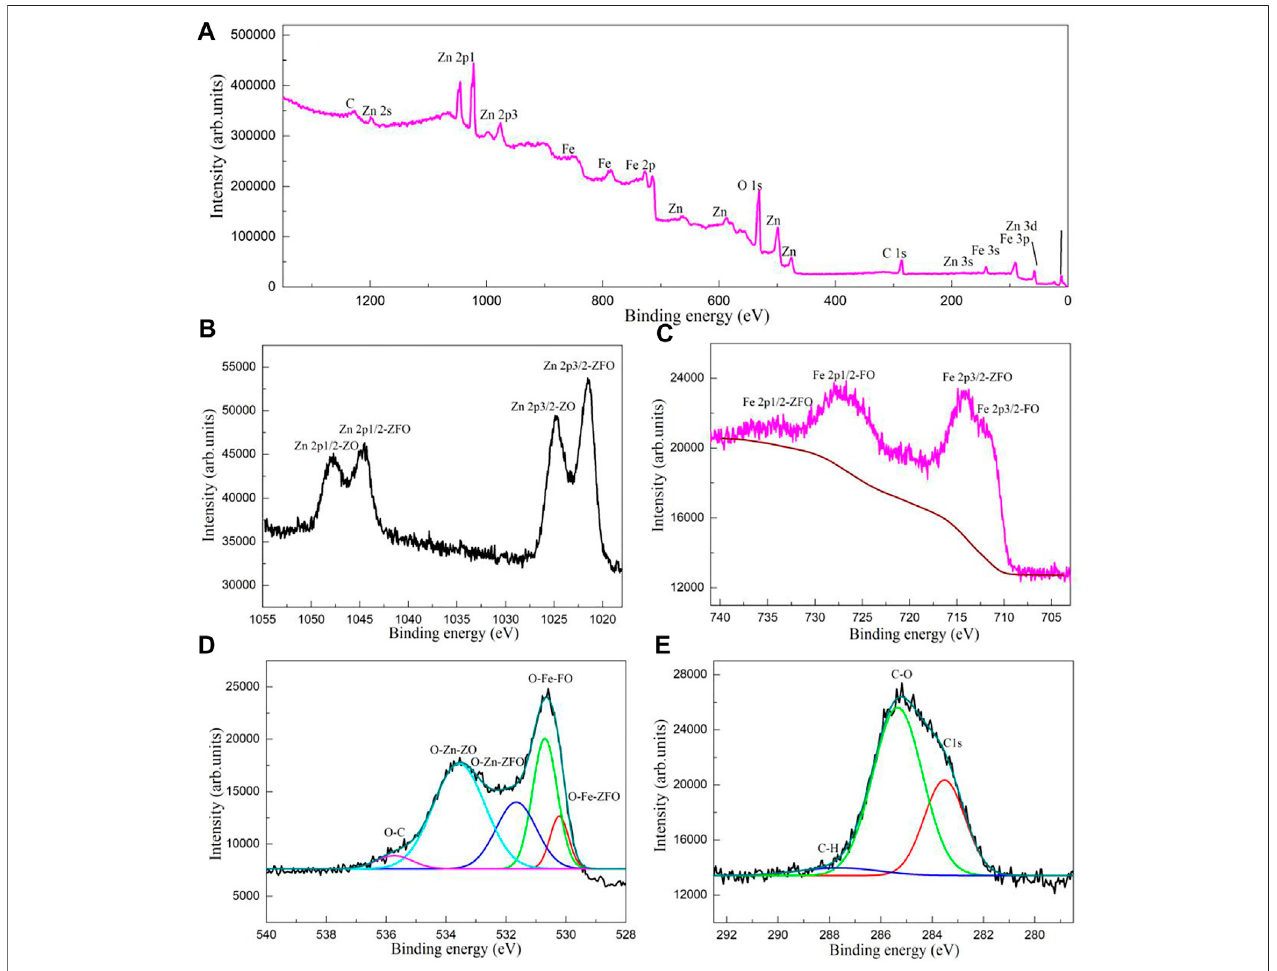
FIGURE 4 | (A) XPS survey spectrum and high-resolution XPS spectra of (B) Zn 2p, (C) Fe 2p, (D) O 1s, and (E) C 1s for the sample GO/ZO/FO/ZFO3.